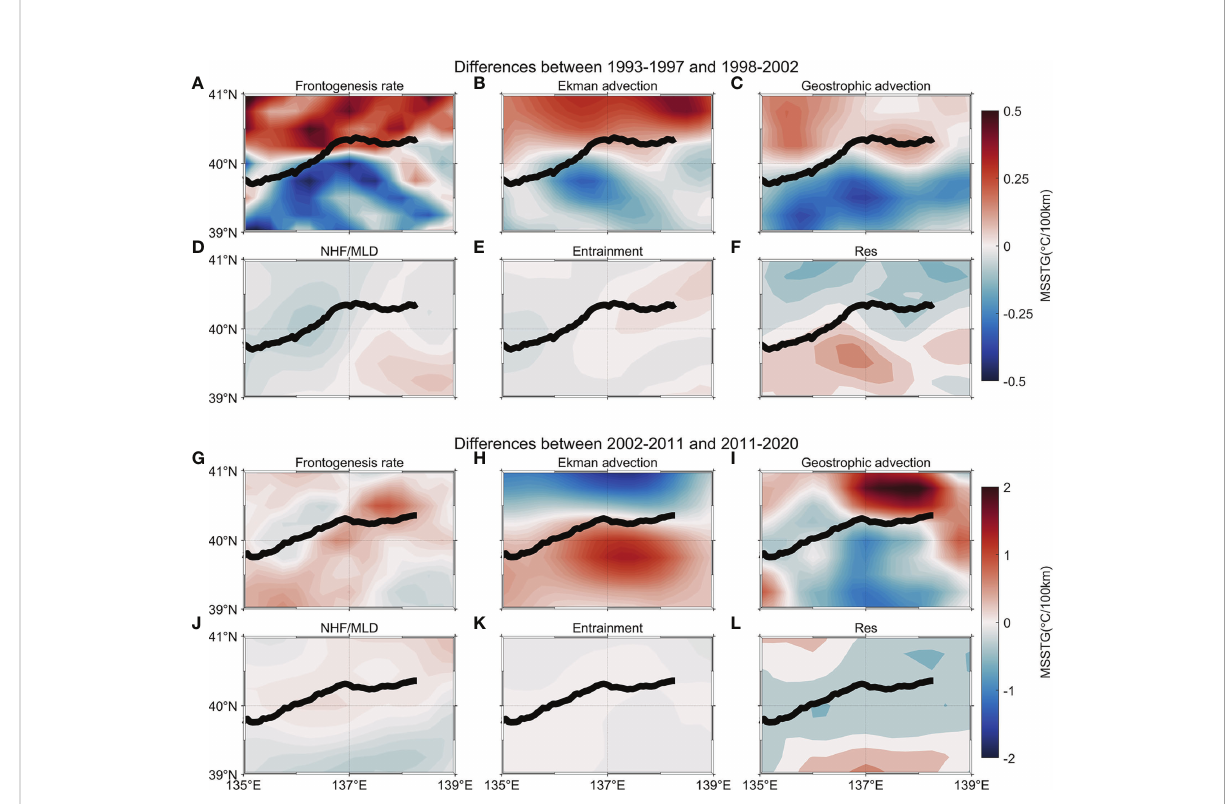
FIGURE 10 (A) Decadal change in the MSSTG between the time periods 1993 – 1997 and 1998 – 2002 (the latter minus the former; unit: °C/100km) calculated from the frontogenesis rate term. (C – F) Same as (A) but for the decadal change in the MSTTG calculated by (B) the Ekman advection gradient term, (C) the geostrophic advection gradient term, (D) the NHF/MLD gradient term, (E) the entrainment gradient term and (F) the differences between the LHS and RHS of equation (3). Black solid lines represent the mean position of the SPF during the time period 1993 – 2002. (G – L) Same as (A – F) but for the changes between the time periods 2002 – 2011 and 2011 – 2020 (the latter minus the former; unit: °C/ 100km) and the mean position of the SPF during the time period 2002 –